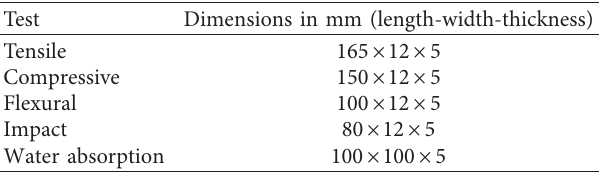
Table 2: Composite specimen dimensions for mechanical and water absorption test.